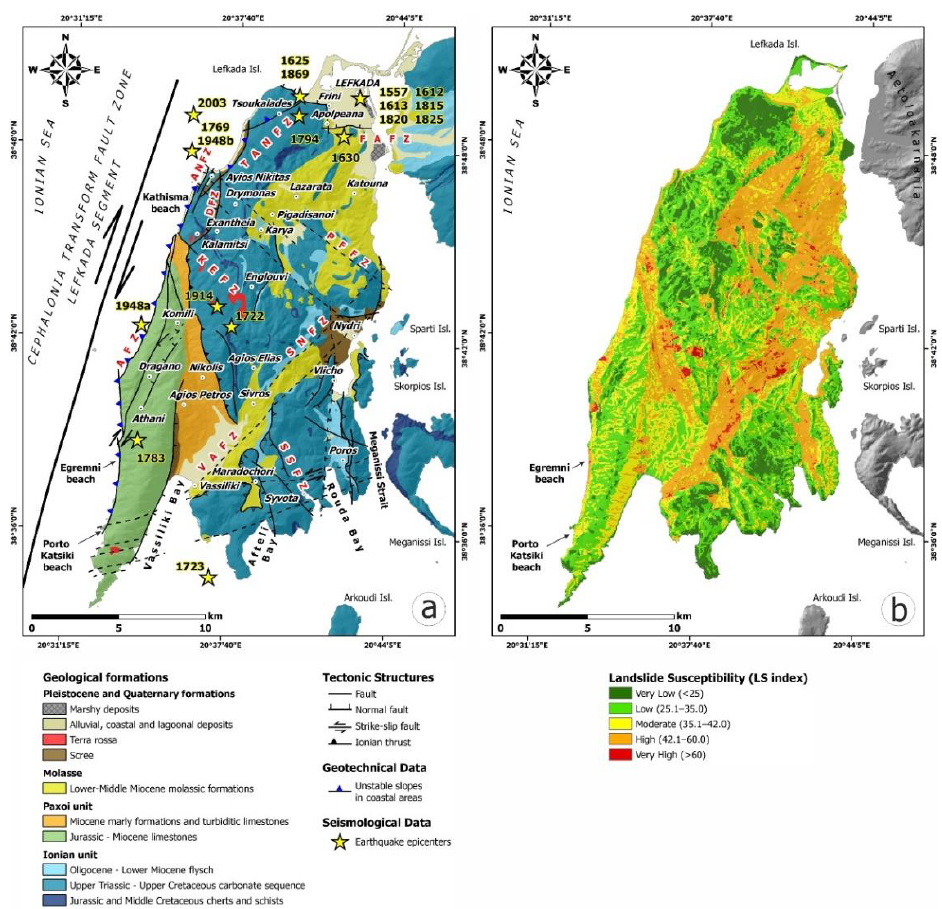
Figure 2. ( a ) The neotectonic map of Lefkada Island from Lekkas et al. [77]. The Egremnoi and Porto Katsiki coastal areas are located in the southwestern part of the fault block of Lefkata peninsula and are composed of Jurassic – Miocene limestones of the Paxoi geotectonic unit. ( b ) Based on the landslide susceptibility map of the Ionian Islands compiled by Mavroulis et al. [82], these slopes are formed in coastal areas highly susceptible to failure.